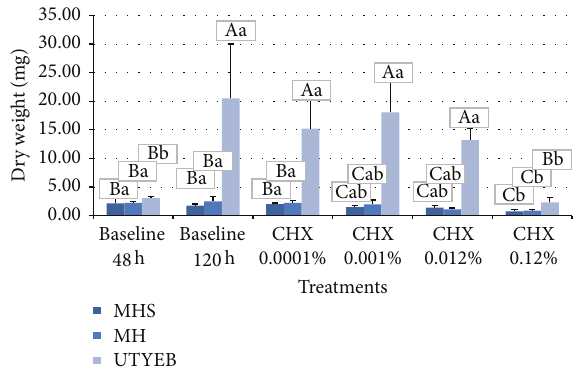
Figure 2: % means and standard deviations of dry weight in the biofilms growth according to the treatments. Capital letters indicate statistical differences between culture media, and lowercase letters indicatestatisticaldifferencesaccordingtothetreatmentsusingeach culture medium, by Tukey test ( 𝑝 < 0.05 ).